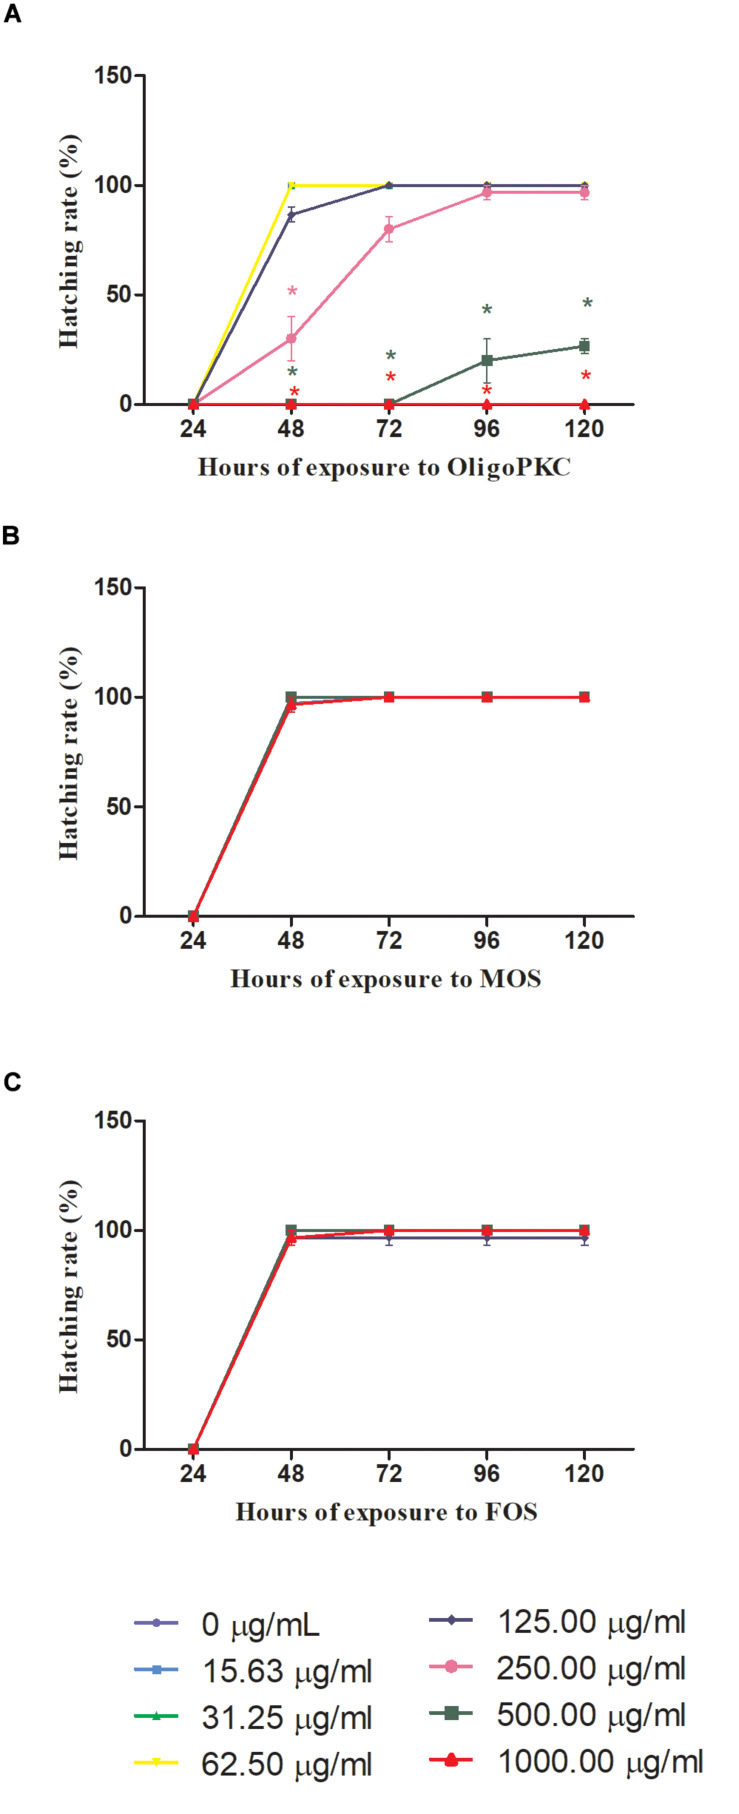
Hatching rates of zebrafish embryos treated with different concentrations of (A) OligoPKC; (B) of MOS and; (C) FOS. Each plotted value represent the mean ± SEM of three biological replicates with each biological replicate containing (n = 10) fishes. Statistical analysis was done using Kruskal-Wallis test followed by Dunn’s Multiple Comparison Test. Means with the symbol “*” are considered significantly different (p ≤ 0.05) compared to the untreated control. Data points appear overlapped at 100% hatching rate.